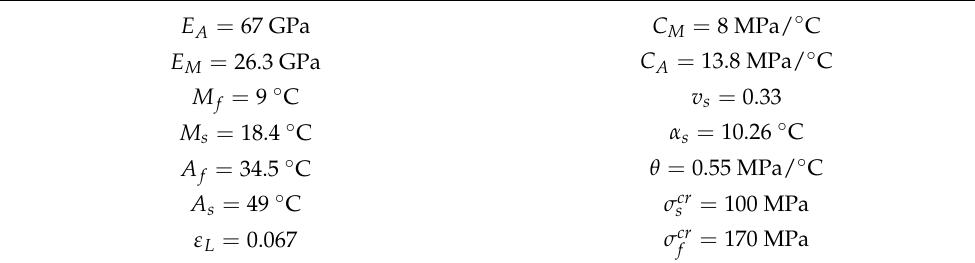
Table 1. Material properties of SMA wires.